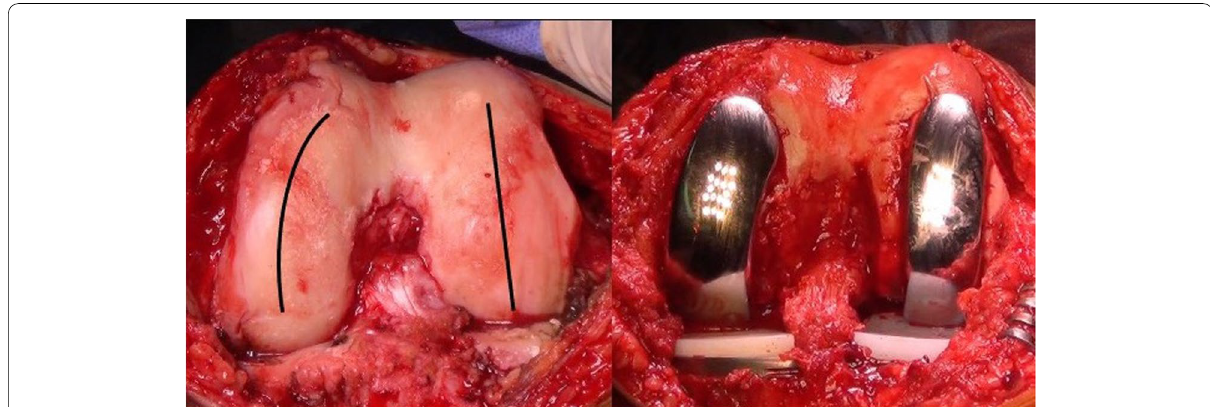
Fig. 6 The two femoral condyles have different shapes. The lateral one is straight, the medial one is curved. Consequently, the two femoral components should have different, dedicated